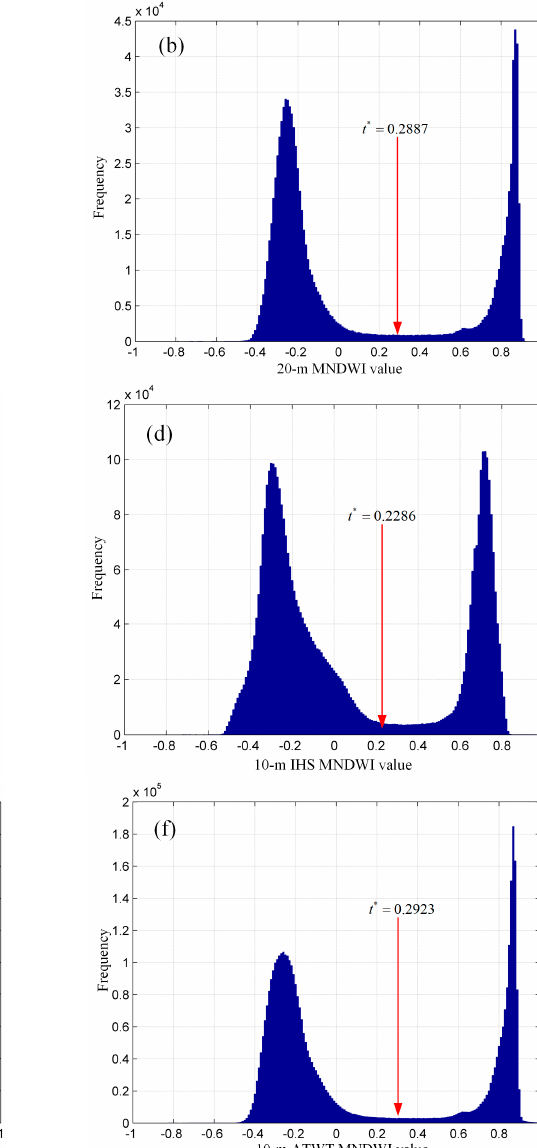
; ( d ) MNDWI IHS ; ( e ) MNDWI HPF ; and ( f ) MNDWI ATWT 10m 10m 10m 10m